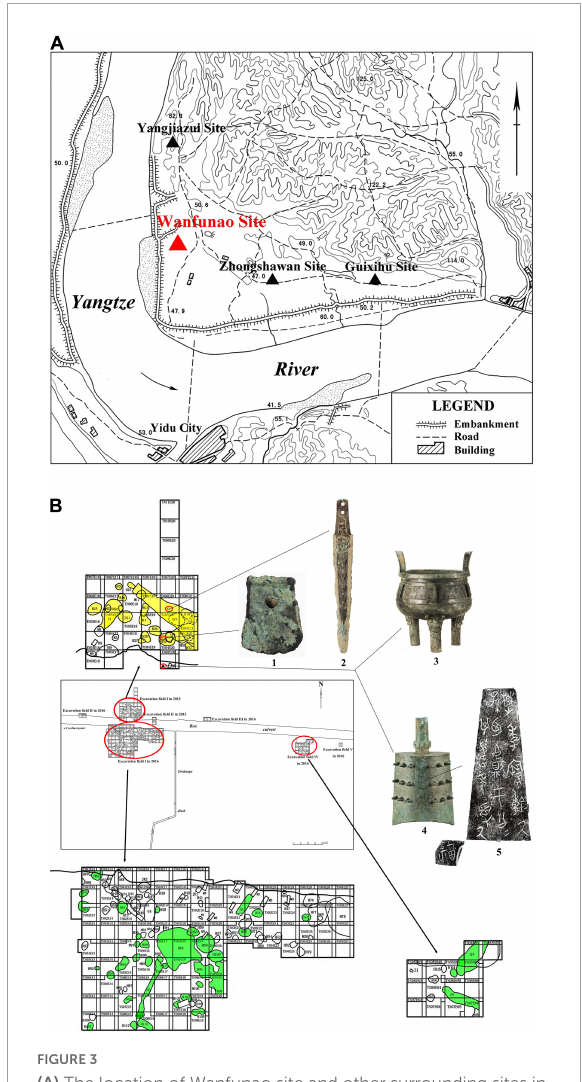
FIGURE3 (A) The location of Wanfunao site and other surrounding sites in Baiyang Industrial Park. (B) Distribution of ruins and bronzes unearthed from Wanfunao. (1) bronze axe (Y1 (cid:172) :1), (2) bronze sword (G2 (cid:173) :1), (3) bronze tripod (TN03E20:13), (4) bronze bell (TN03E20:1), and (5) inscription of bronze bell (TN03E20:1).